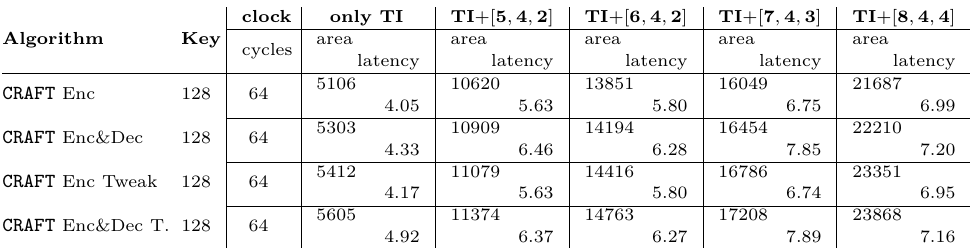
Table 7: Area (GE) and Latency (ns) of round-based Threshold Implementations of -bounded univariate adversary with an [ n, k, d ] CRAFT with 3 shares considering an M t = d − 1 code, using the IBM 130 nm ASIC